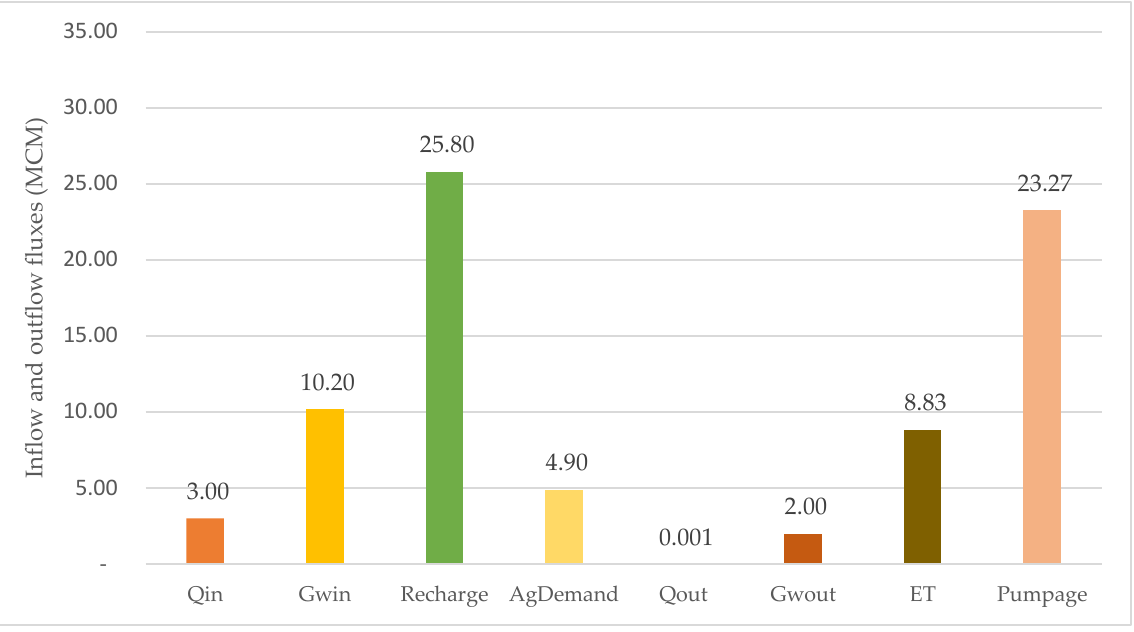
Figure 3. The 1954–2020 average annual percentages of inflow and outflow fluxes to the SCRA-MX basin.